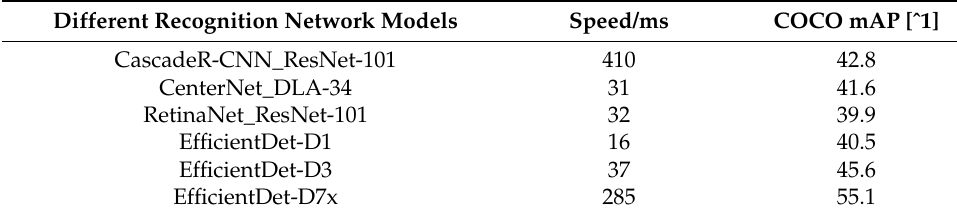
Table 1. Performance of different identification network models.